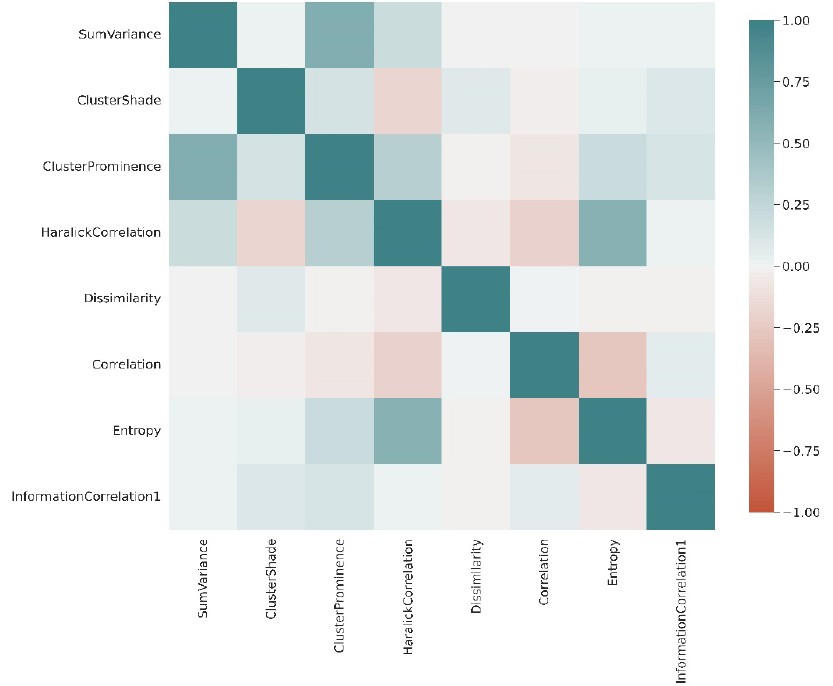
Figure 5. Correlation matrix plot of the 8 least-correlated textural features generated from the pan- chromatic